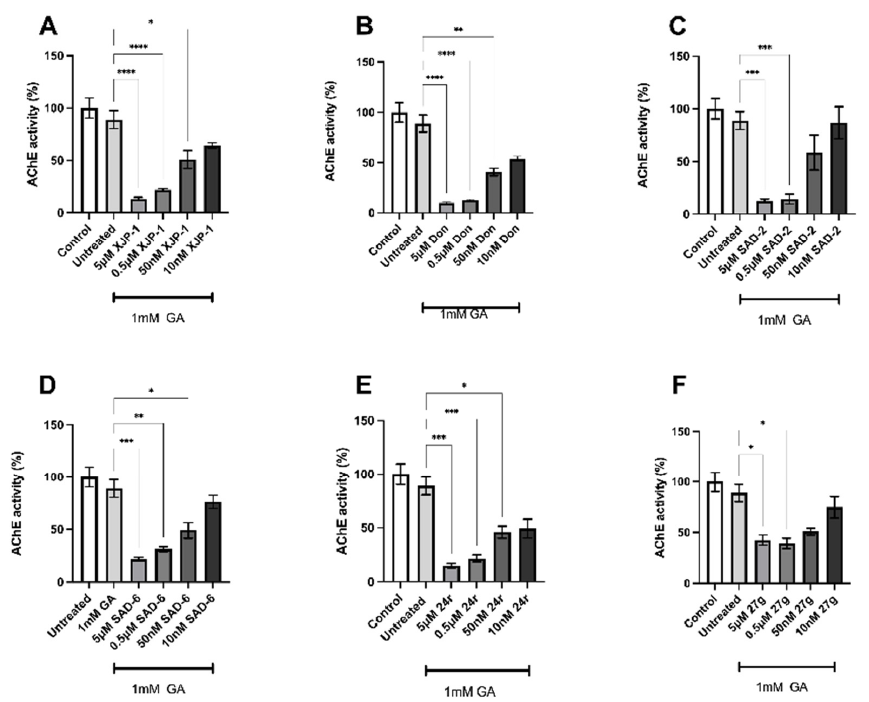
Figure 3. AChE inhibition by novel compounds at different concentrations in 1 mM GA-exposed SH-SY5Y-derived neurons. ( A ) Inhibitory activity of compound XJP-1 in 1 mM GA-exposed neu- rons. ( B ) Inhibitory activity of compound Donepezil in 1 mM GA-exposed neurons. ( C ) Inhibitory activity of compound SAD-2 in 1 mM GA-exposed neurons. ( D ) Inhibitory activity of compound SAD-6 in 1 mM GA-exposed neurons. ( E ) Inhibitory activity of compound 24r in 1 mM GA-exposed neurons. ( F ) Inhibitory activity of compound 27g in 1 mM GA-exposed neurons. Ordinary one-way ANOVA followed by Tukey’s post-hoc test was used to compare differences between different groups. Data are presented as mean ± SEM. n = 3. * p < 0.05; ** p < 0.01; *** p < 0.001; **** p < 0.0001. 2.3. AChE Inhibition Prevents GA-Induced Tau Phosphorylation on S396 but Not on S199 After validating the inhibitory activity of the novel compounds on the AChE enzyme (Figures 2 and 3), we investigated whether GA-induced Tau hyperphosphorylation could be prevented by AChE inhibition exerted by novel compounds. The exposure of neuronal cells to 0.7 mM GA dramatically increased Tau phosphorylation levels on S199 (Figure 1D), whilst AChE inhibitor XJP-1, at 5 μ M and 0.5 μ M concentrations, significantly re- duced Tau hyperphosphorylation on S199 in neurons treated with 0.7 mM GA (Figure 4A), with the same trend being followed by the control AChE inhibitor Donepezil (Figure 4B). On the other hand, treatment with novel AChE inhibitors SAD-2 did not reduce S199 phosphorylation in 0.7 mM GA-exposed SH-SY5Y-differentiated neurons (Figure 4C), whilst compounds SAD-6 and 24r recorded a significant reduction of S199 abnormal